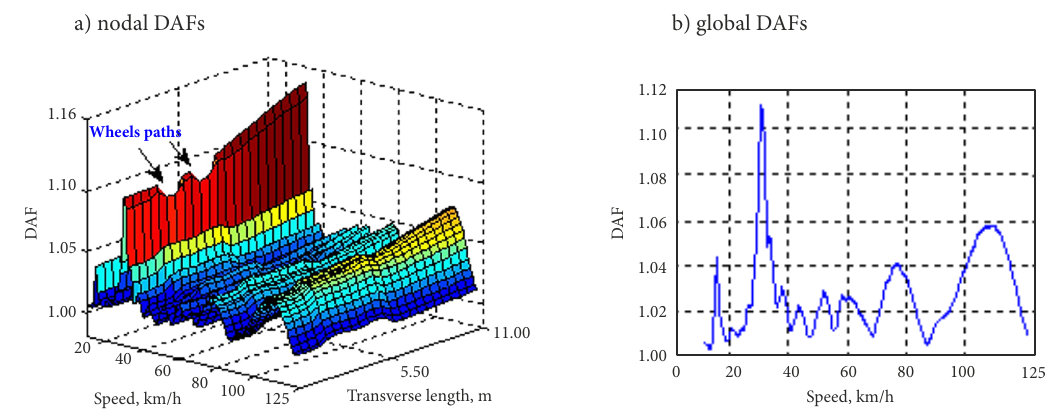
Figure 10. DAF-speed pattern for plate model due to a series of 38 moving point loads travelling with an eccentricity with respect to the bridge centreline